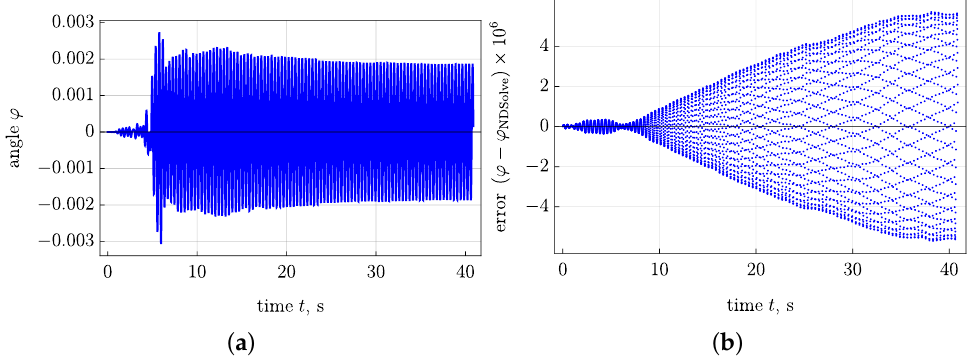
Figure 4. ( a ) Angle ϕ over time t for Kobe earthquake data with proposed method, the computation time is 0.40 s (for NDSolve of Mathematica the time history is visually indistinguishable and the computation time is 1.45 s). ( b ) Absolute deviation between solutions with our method and